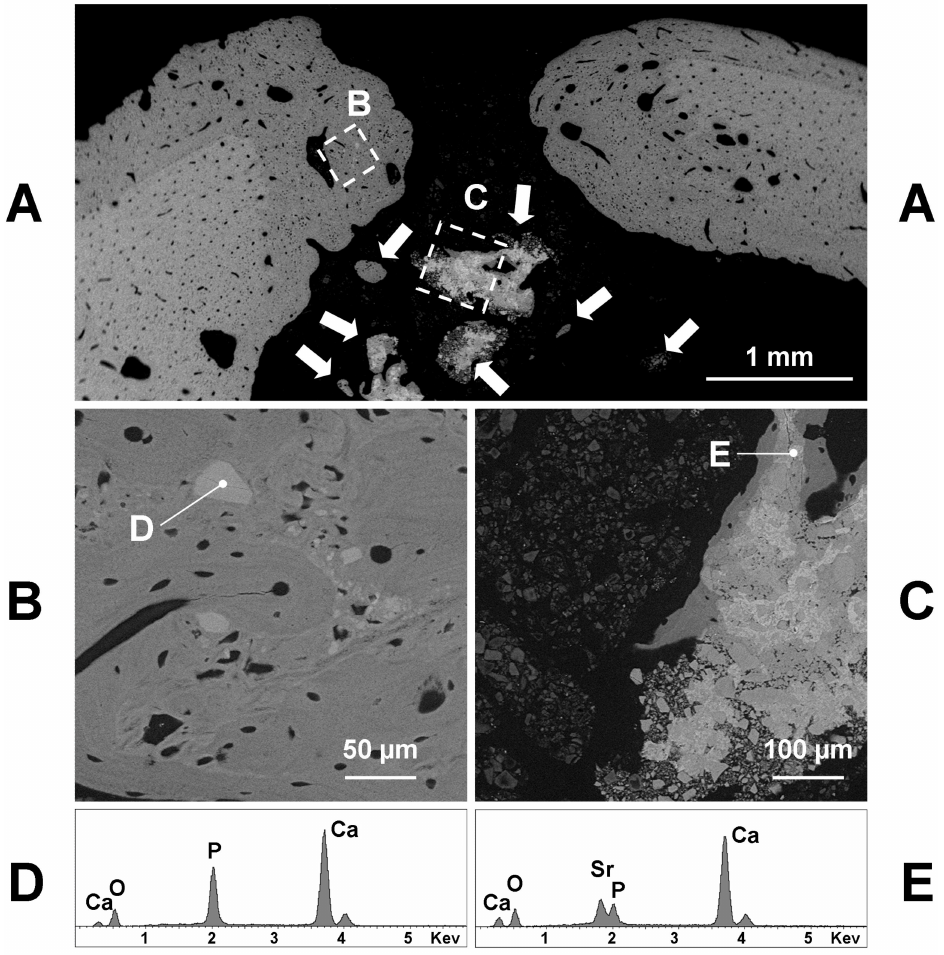
Figure 4. Representative backscattered SEM images of a transverse section taken at the central part of a BGSr filled hole, 60 days after the surgery, showing several isolated bone formations (arrows) inside the medullar cavity. The B and C boxed areas of A correspond to the remodeled bone ( B ) and to an isolated bone formation ( C ), at a greater magnification. The newly formed bone (darker in A ) contains several irregularly shaped osteocytes ( B ) and includes some granules ( D ) consisting of calcium phosphate, as shown by the X-ray microanalysis ( D ). The isolated bone formations, surrounded by the remnants of the implanted glass ( C , on the left), often contain mineral granules (lighter in C ) consisting of calcium phosphate with amounts of strontium, as shown by the X-ray microanalysis ( E